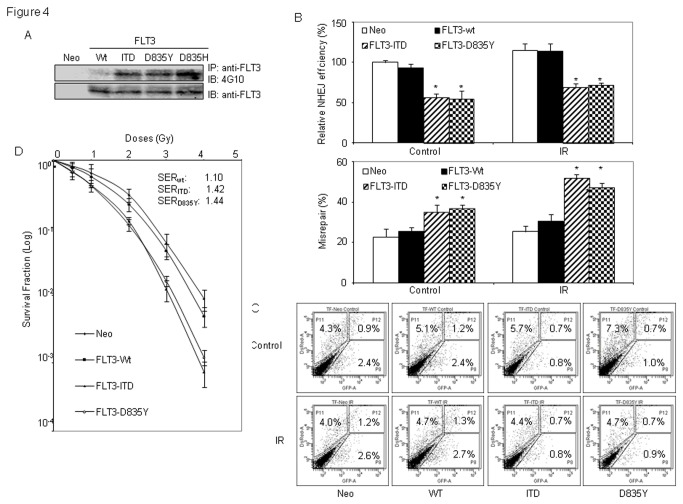
Expression of FLT3/ITD or FLT3/D835 mutation decreases the efficiency and fidelity of end-joining repair, and cause hypersensitivity to IR in AML cells.TF1 cells were engineered with stable expression of wild-type FLT3, or different forms of mutant FLT3, or empty vector as control. (A) Mutant FLT3 proteins with ITD or FLT3/D835 mutation are constitutively activated. Whole cell extracts were prepared and immunoprecipitated (IP) with anti-FLT3 antibody. Immunoblot assay (IB) was performed with anti-phosphotyrosine 4G10 antibody (upper panel). The membrane was then stripped and re-probed with anti-FLT3 antibody (lower panel). (B and C) Engineering expression of mutant FLT3 protein reduces the in
vivo end-joining efficiency and increases misrepair frequency in TF1 cells. (B) Engineered TF1 cells were co-transfected with linear pUC18 and circle pDsRed as control. Cells were either irradiated with 1.2 Gy or untreated. Plasmid DNAs were then recovered from cells 72 hours later, and transformed into E.Coli for white/blue clone screening. End-joining efficiency (top) and misrepair frequency (bottom) were calculated according to the numbers of colony formed as described in Methods and Materials. Diagram shows changes of the in
vivo end-joining efficiency and misrepair frequency; (C) as an alternative approach, engineered TF1 cells were co-transfected with linear EJ5-GFP reporter and circle pDsRed and irradiated. GFP+ cells were measured by flow cytometry assay, and the ratios of GFP+ / RED+ cells were calculated to determine the end-joining repair efficiency. Flow cytometry results represent one of three independent experiments. (D) AML cells expressing constitutively activated mutant FLT3 are more sensitive to IR. Engineered TF1 cells were treated with 200nM SAHA followed by IR. Clonogenic survival assay were performed as described in materials and methods. Data represents the average of three experiments. Error bars indicate standard deviation. * indicates significance (P<0.05).